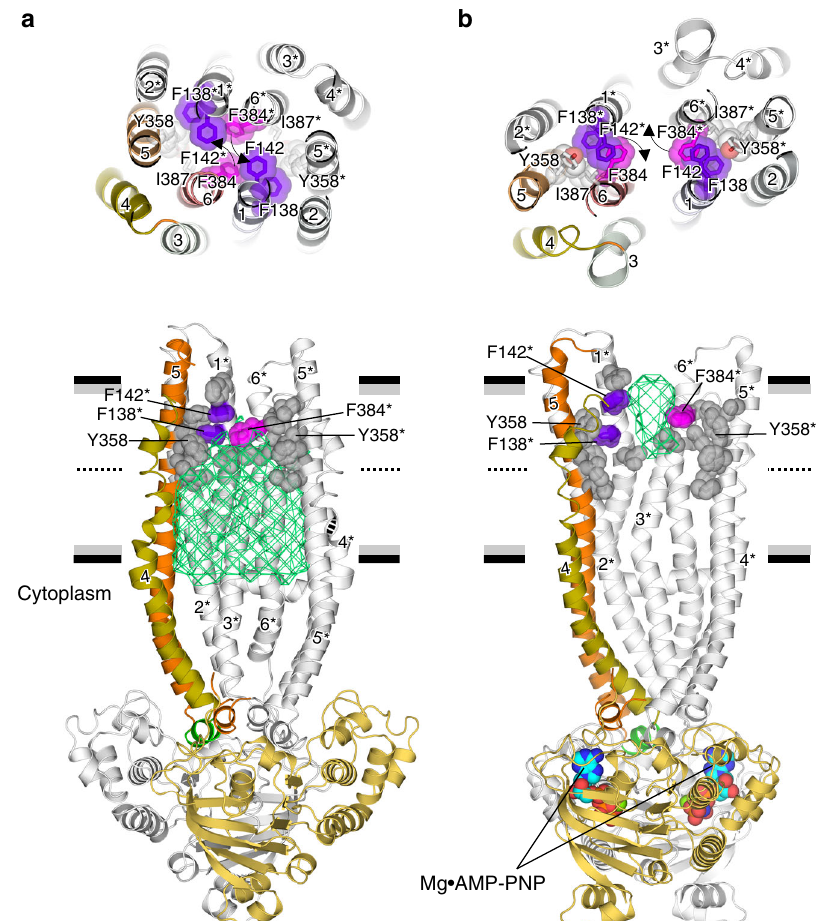
Fig. 2 Structural changes forming a substrate pathway from the inner side to the extracellular side. Rearrangement of side chains, primarily in TM1, TM6, TM1*, and TM6*, between inward- ( a ) and outward-facing ( b ) conformations of QTA CmABCB1. (Upper panels) Top views of the extracellular gate, showing transition of residues lining TM1, TM6, TM1*, and TM6*. (Lower panels) Lateral views of both structures. For clarity, several TM helices (TM1, TM2, TM3, and TM6) are omitted. One subunit is colored in orange, and the other is shown in gray. The inner chamber in the inward-facing conformation is shown as a green mesh ( a ). In b , bound Mg 2 + (cid:129) AMP-PNP molecules at NBDs are shown as spheres. Horizontal black and gray bars represent the expected positions of the hydrophilic and hydrophobic surfaces of the lipid membrane,